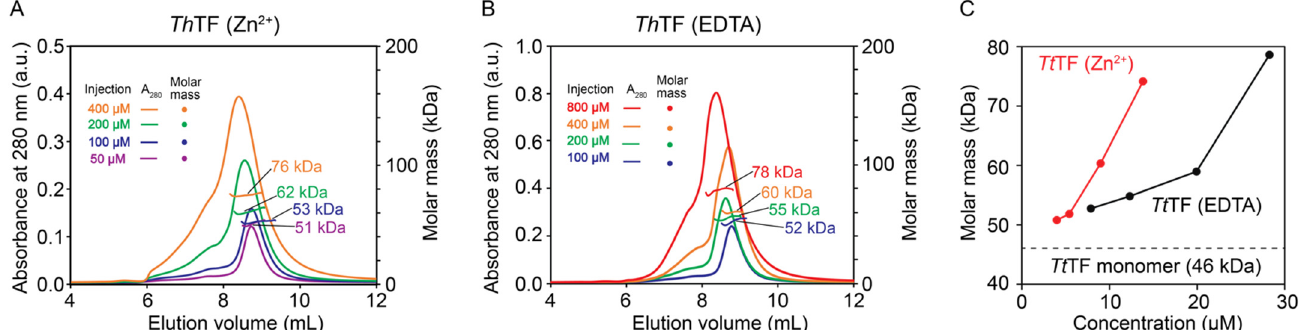
Figure 4. SEC-MALS for the investigation of the oligomeric state of Tt TF. ( A , B ) SEC-MALS profiles of Tt TF (Zn 2+ ) ( A ) and Tt TF (EDTA) ( B ) injected at varying concentrations. At higher concentration, the larger molar mass was observed for Tt TF (Zn 2+ ) and Tt TF (EDTA), indicating the increase of the oligomeric fractions at higher concentrations. ( C ) Plots of the molar masses of Tt TF (Zn 2+ ) (red) and Tt TF (EDTA) (black) with respect to the concentrations measured by the refractive index at the peak top. Note that Tt TF is diluted after injection into the SEC column, and thus, the concentration at the peak top is lower than that at the injection. a.u., arbitrary unit.